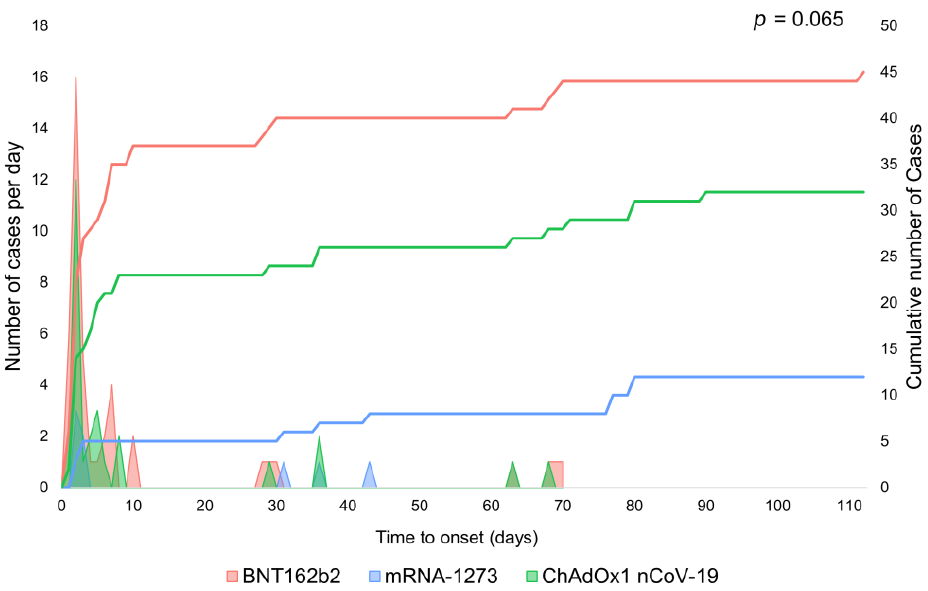
Figure 1. Time to onset of systemic capillary leak syndrome after vaccination with different types